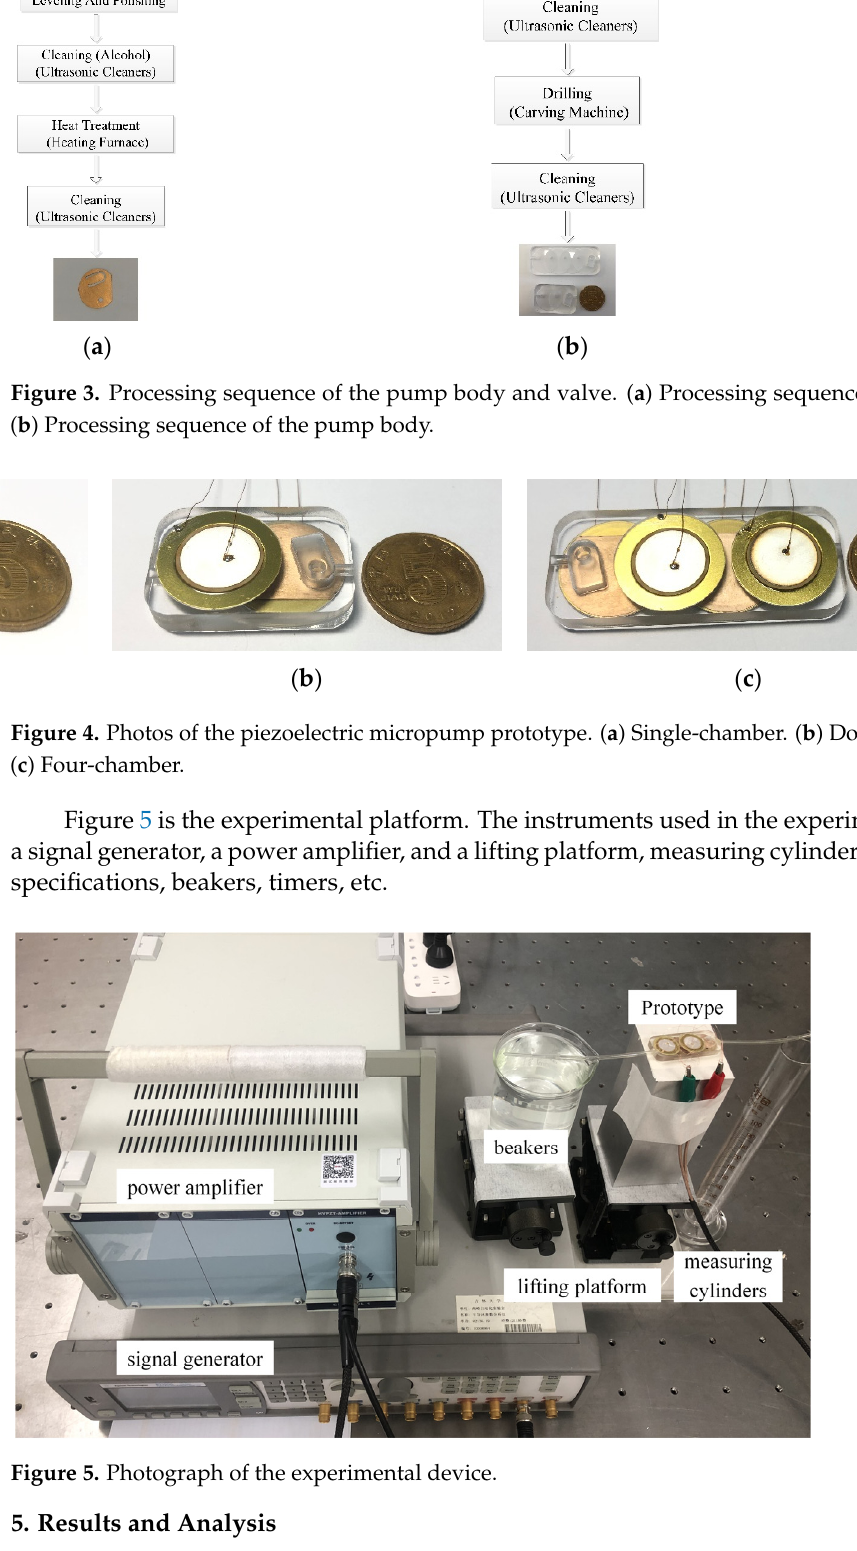
Figure 5. Photograph of the experimental device.